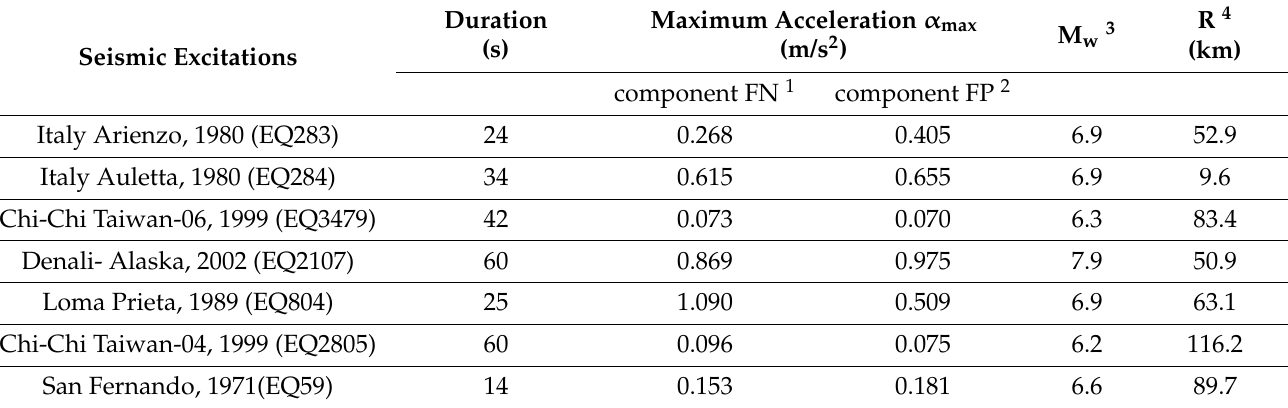
Table 1. Main characteristics of seismic